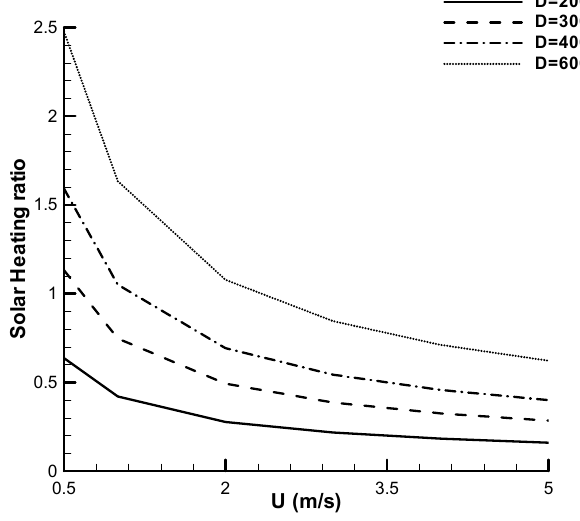
Figure 6. Solar heating ratio defined as ∆ T s / ∆ T hx for different air velocity values.